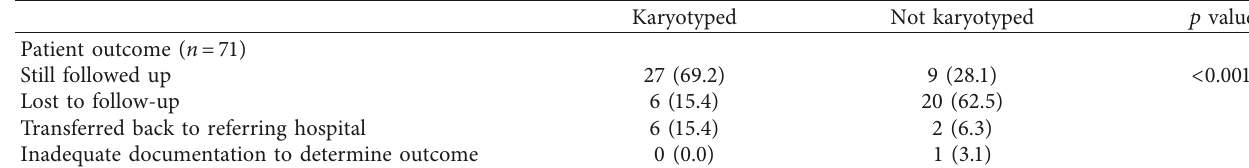
Table 3: Karyotyped and nonkaryotyped patients in terms of